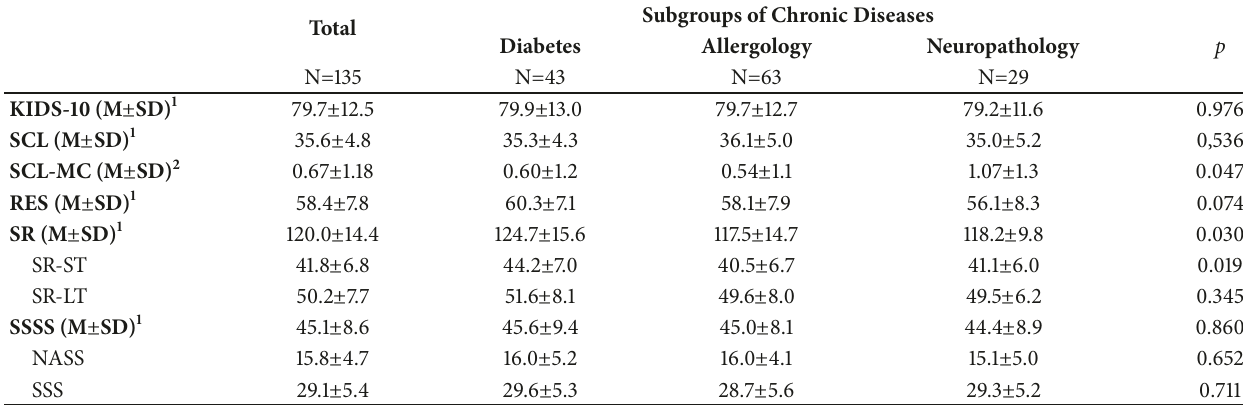
Table 3: Differences between the groups of adolescents with diverse chronic diseases for all psychosocial